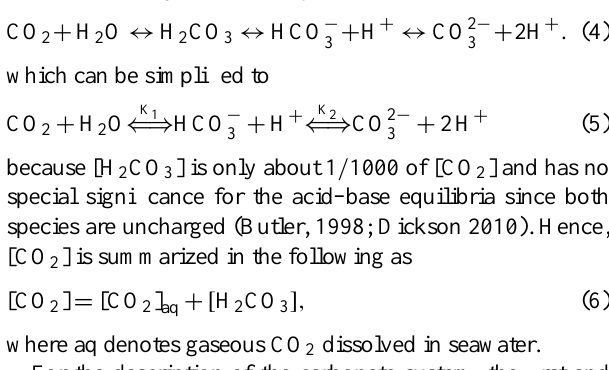
Figure 1. Change in different surface ocean carbonate-chemistry parameters under “business-as-usual” climate change scenario SRES (Special Report: Emissions Scenarios) A2 with (a) increas- ing atmospheric p CO 2 and (b) over time. All changes are relative to the preindustrial CO 2 partial pressure of ∼ 280µatm. Note that the slight deviations from proportionality between [CO 2 − and [HCO − ] / [H + ] are the result of changes in global average tem- 3 perature and salinity in the course of climate change which affect K ∗ and K ∗ sp (see Sect. 3.5 for further 2